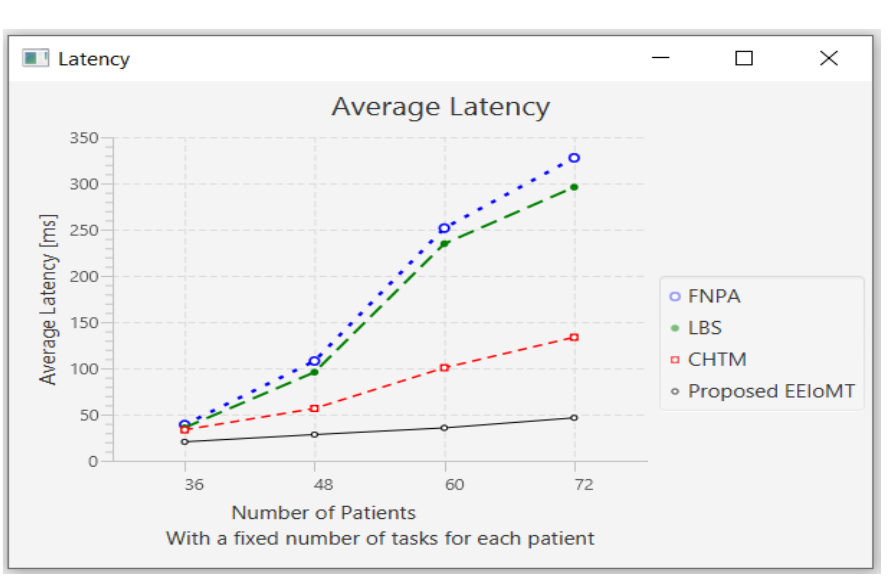
Figure 8. Average latency comparison when changing the number of patients.